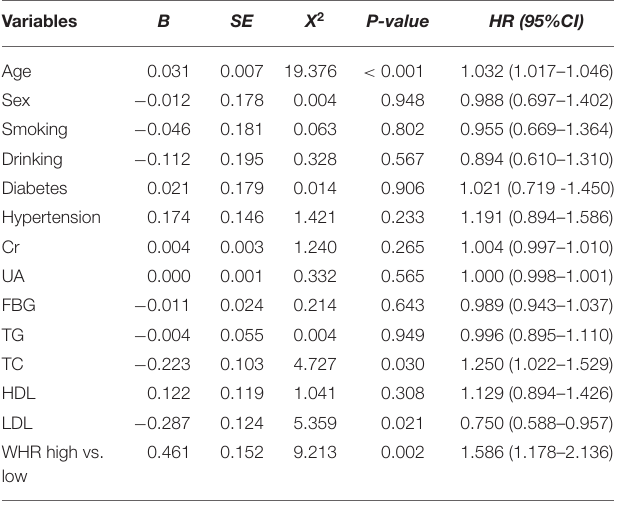
TABLE 3 | Cox regression analysis results for ACS long-term mortality. TABLE 4 | Cox regression analysis results for stable CAD long-term